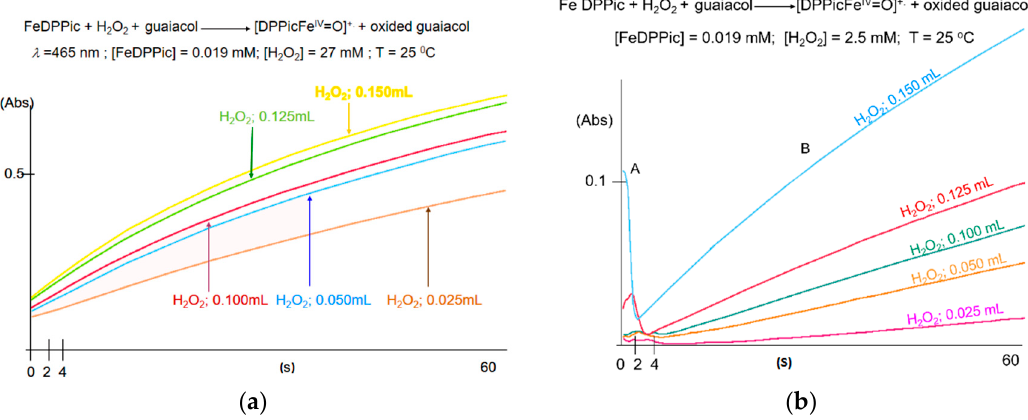
Figure 2. ( a ) Single kinetics showing only the guaiacol oxidation products; ( b ) Two types of kinetics, oxidation of A pinch-porphyrin and B guaiacol, or three in some cases, were observed when 2.5 mM [H 2 O 2 ] was added, one magnitude order lower than for activity catalytic studies.